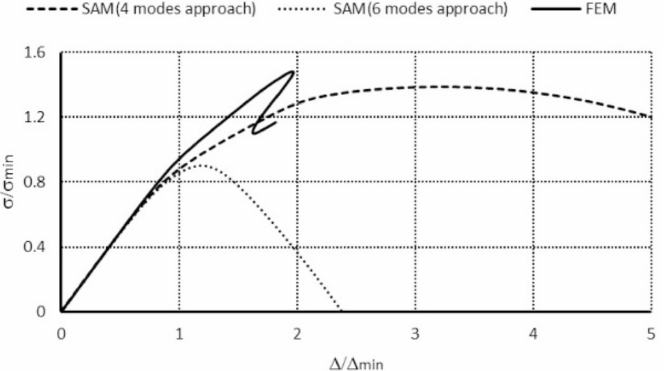
Figure 9. Comparison of dimensionless equilibrium paths for channels of the total length L = 250